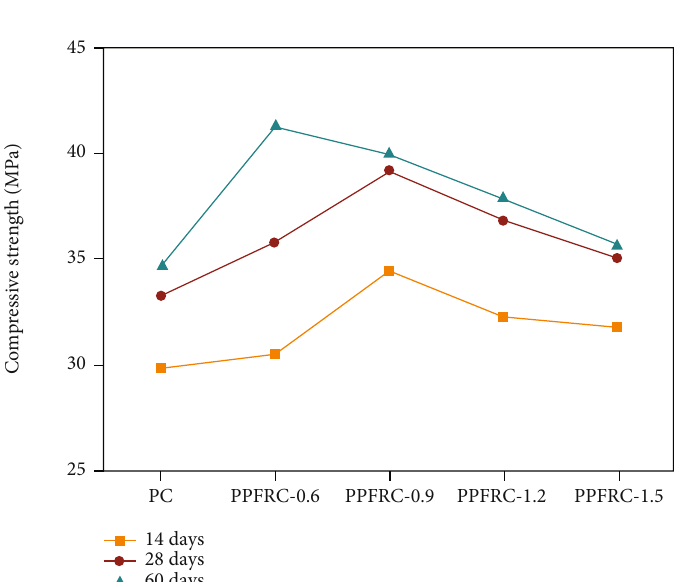
Figure 12: Compressive strength at 14, 28, and 60 days of curing.